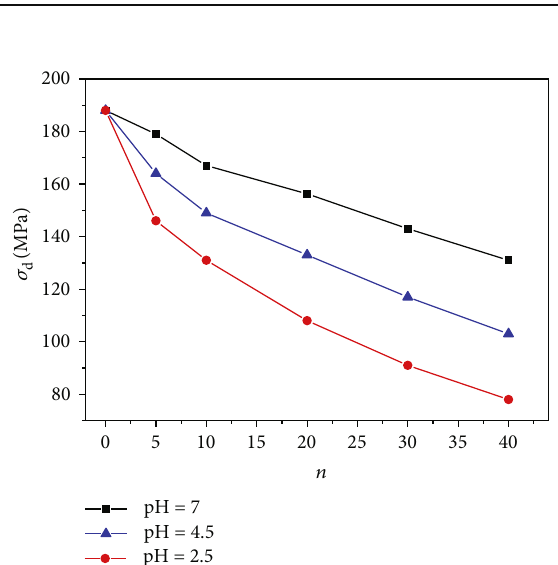
Figure 4: Variation of dynamic UCS of red sandstone versus n